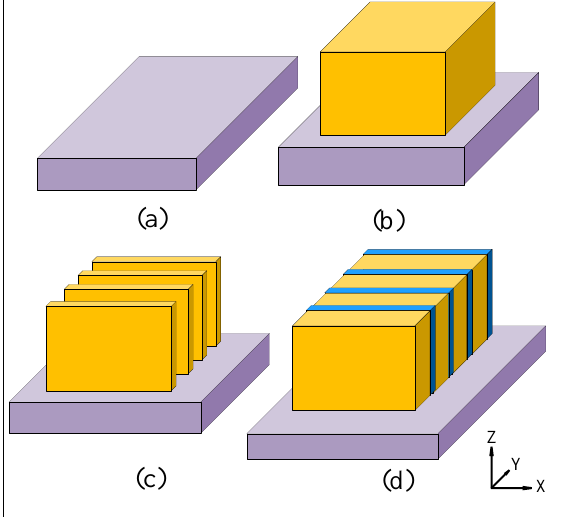
Figure 5. Proposed schematic of coupled MQW fabrication process. ( a ) The substrate is provided for the growth of the designed layers (substrate is common to electronic section and the optical section of the modulator on which the PhCs is also implemented). ( b ) GaAs layer is grown to size in the intrinsic region of the p-i-n diode for deposition and patterning of coupled MQWs. ( c ) GaAs MQWs are formed and developed by mask and pattern process of the previous step to maintain the GaAs MQWs and vacant MQWs. Vacant MQWs are created by etching process. ( d ) AlGaAs layers are deposited in vacant MQWs. Therefore, an intrinsic is region created for the p-i-n diode via coupled